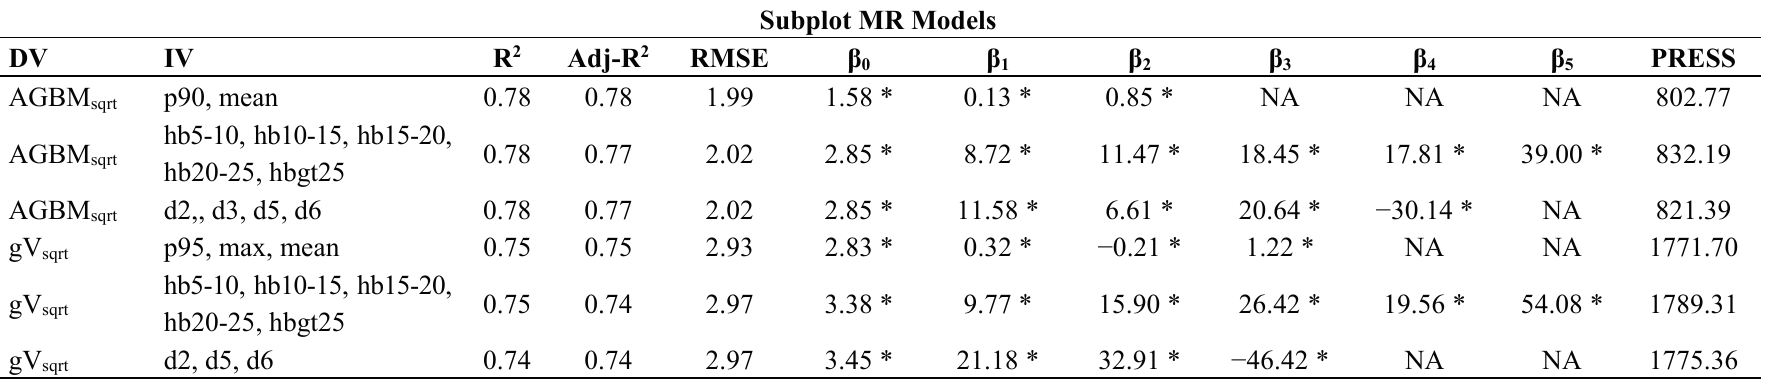
Table 10. Subplot-level multiple regression analysis results. * indicates p -values of less than 0.05.